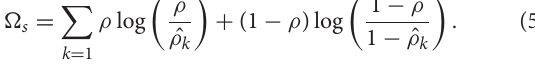
dimensional space to identify manifolds in the system. We use